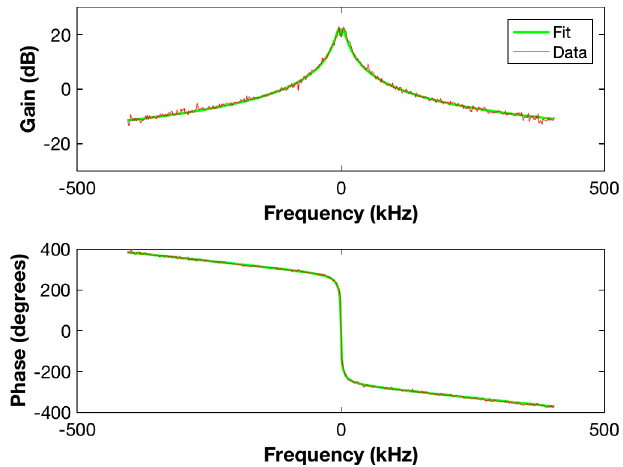
FIG. 6. LHC Cavity 1B1 measured and modeled open loop transfer function ( Q L ¼ 20000 ).